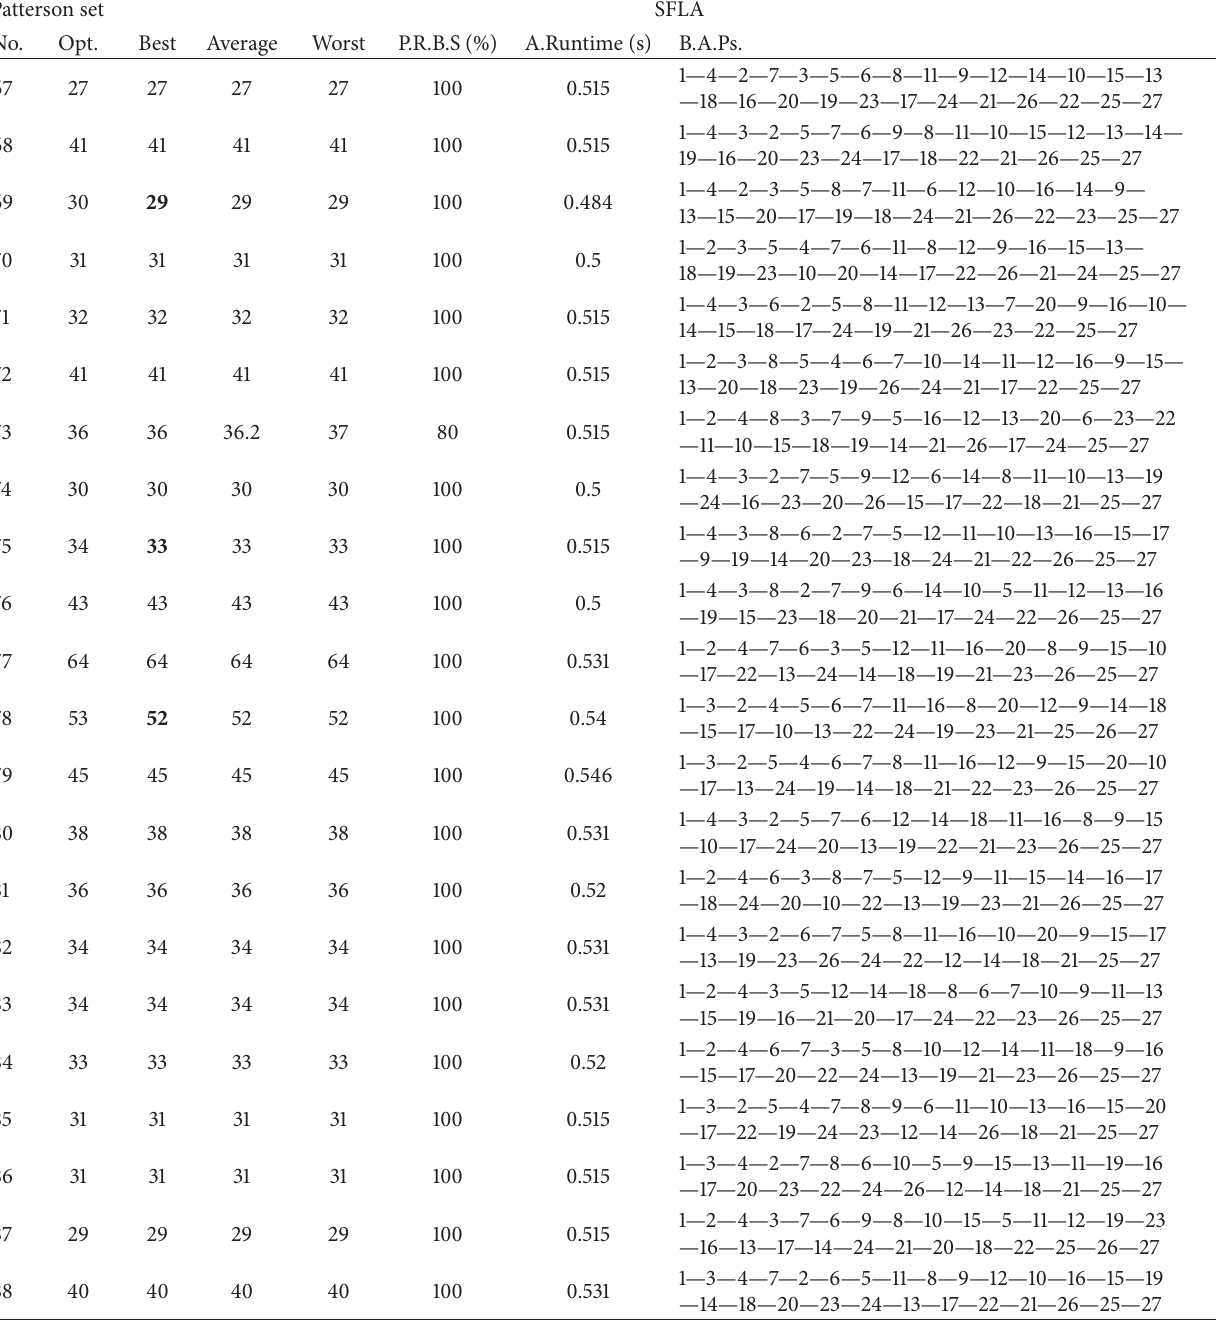
Table 4: Computational results of RCPSP PA SFLA for Patterson set